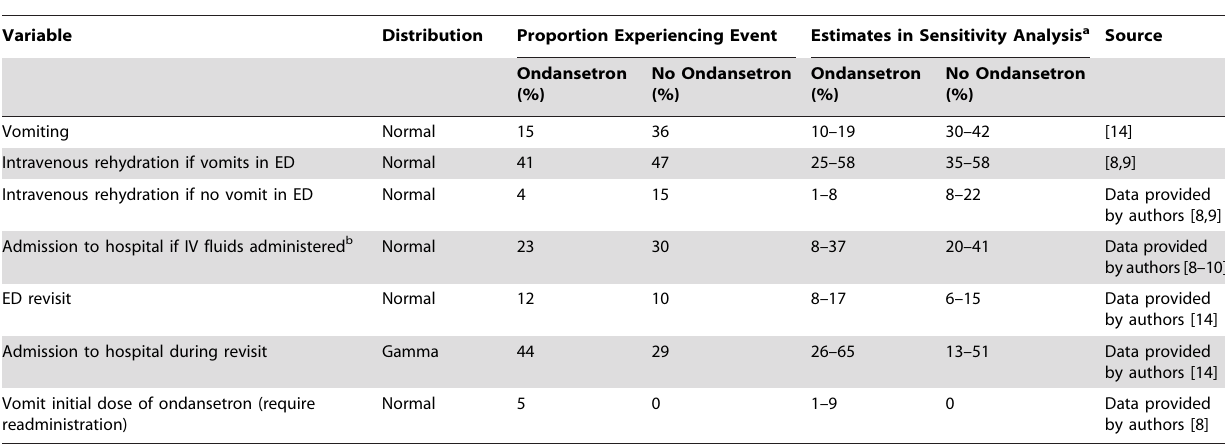
Table 1. Ondansetron efficacy estimates used in the cost